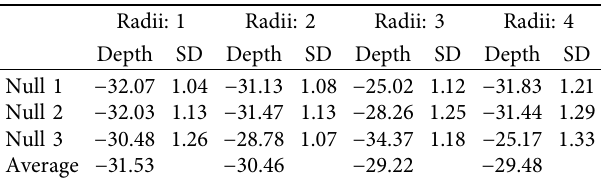
Table 20: Nulling accuracy (in degrees) corresponding to null steering at wavelength normalized radii 1, 2, 3, and 4 (as per the average array factor).